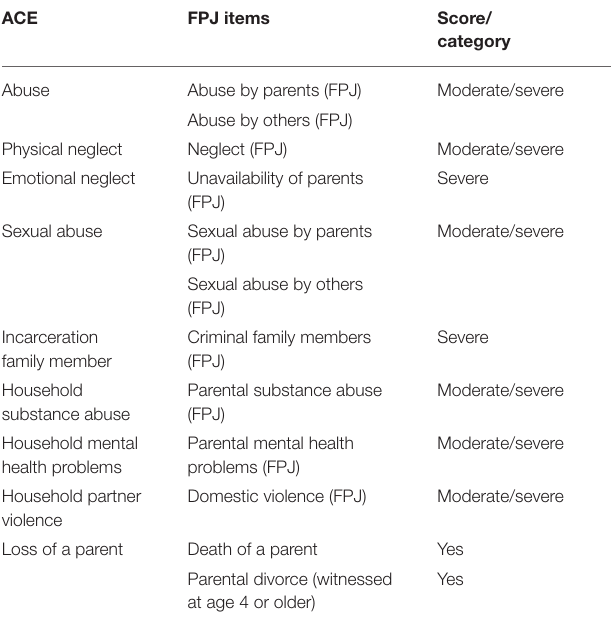
TABLE 2 | Scoring protocol for the presence of ACEs based on